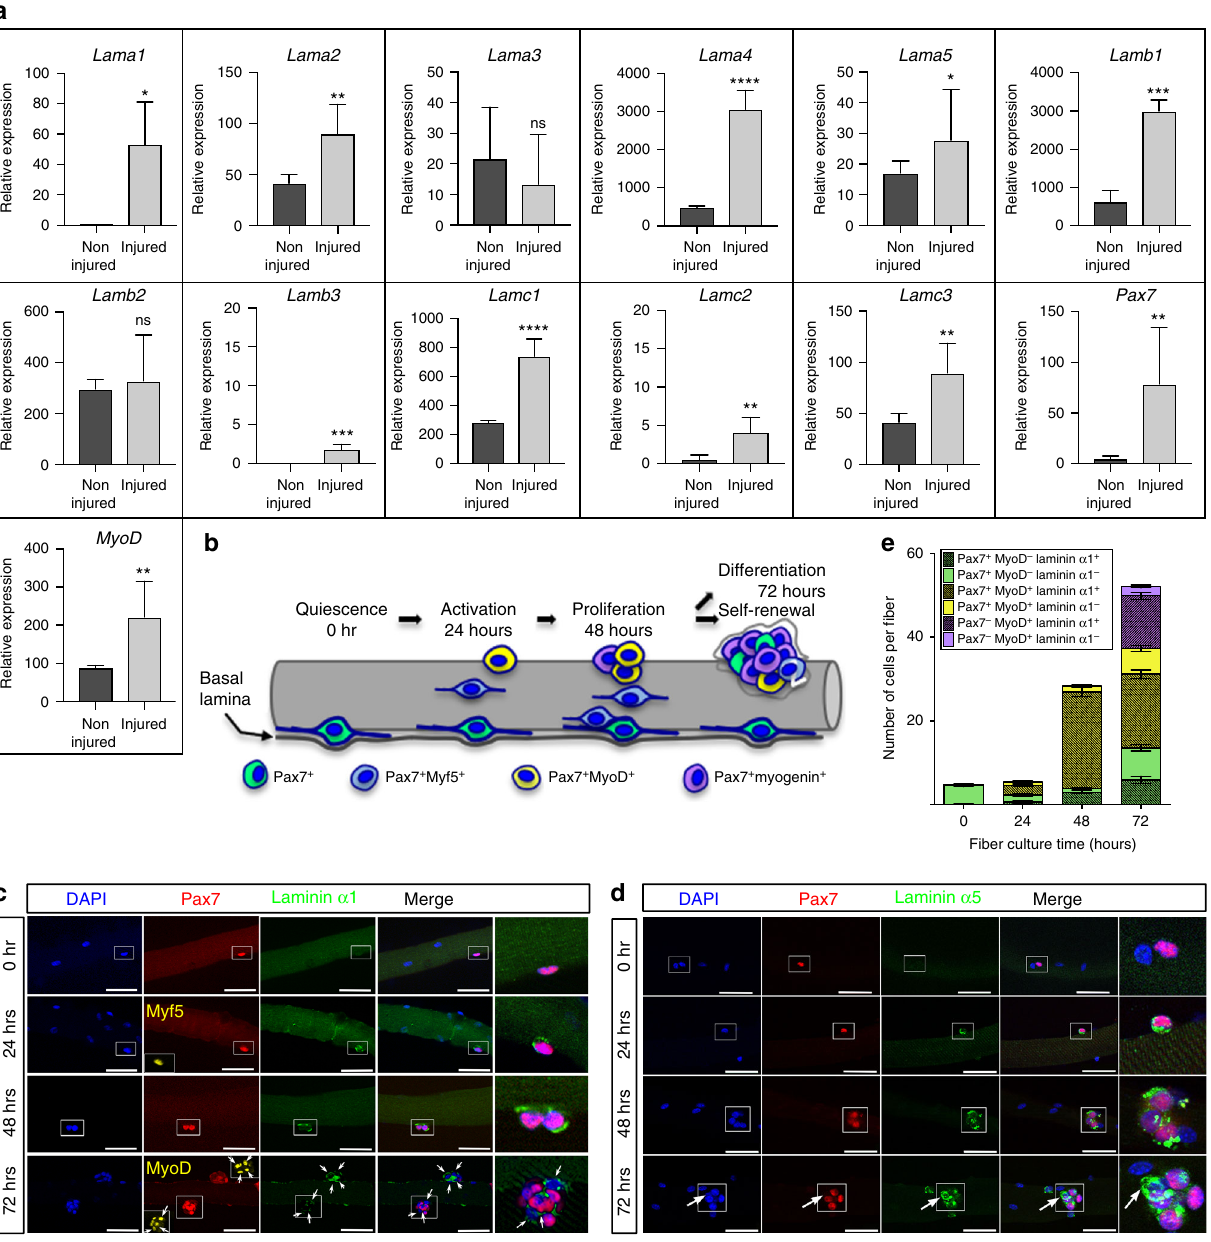
Fig. 1 Laminin- α 1 and laminin- α 5 deposition in the niche of activated satellite cells. a Quantitative PCR analysis of Lama1-5 , Lamb1-3 , and Lamc1-3 genes together with Pax7 and MyoD in non-injured (dark gray; n = 3) and 4 dpi injured (light gray; n = 3) TA muscles. b Schematic representation of the myo fi ber culture system showing the sequential activation (blue), proliferation (yellow), self-renewal (green), and differentiation (purple) of satellite cells. c Representative immuno fl uorescence images of cultured myo fi bers analyzed for laminin- α 1 (green), Pax7 (red), Myf5 (yellow at 24 h), and MyoD (yellow at 72 h). Panels on the right are high magni fi cation images of the area boxed. White arrows indicate satellite cells associated with laminin- α 1. Scale bar, 50 μ m. d Immuno fl uorescence analysis of laminin- α 5 (green) and Pax7 (red) distribution in cultured myo fi bers. Arrows indicate Laminin- α 5 deposition in Pax7 − cells at 72 h. Scale bar, 50 μ m. e Quanti fi cation of the number of satellite cells expressing Pax7, MyoD, and laminin- α 1 after myo fi ber culture. The color code relates to the cell populations described in ( b ). n = 3 experiments with 20 – 32 fi bers analyzed per time point. Graph shows mean + sem; * P < 0.05, ** P < 0.01, *** P < 0.001, **** P < 0.0001 ( t -test)